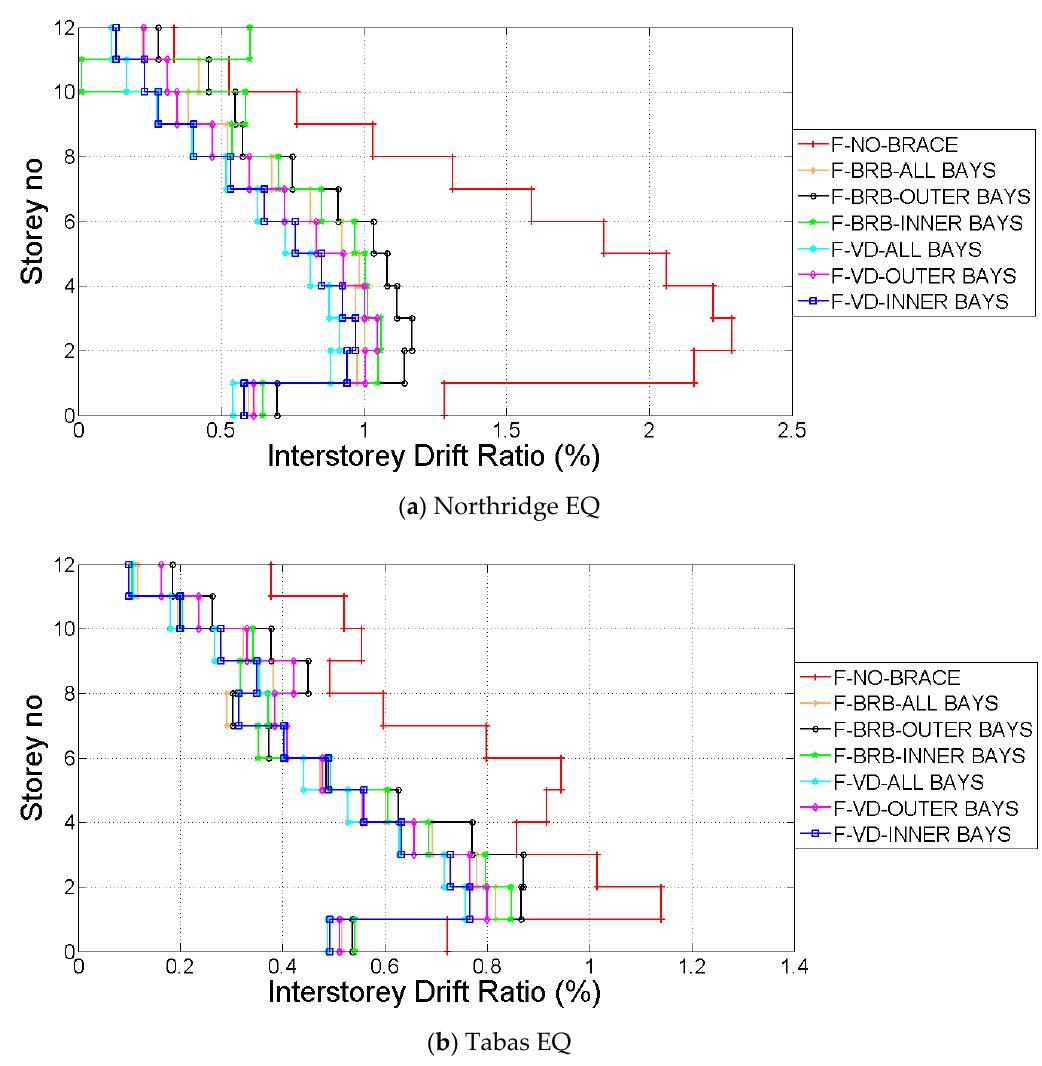
Figure 12. Variation of interstory drift ratio with story level in 12-story frames.